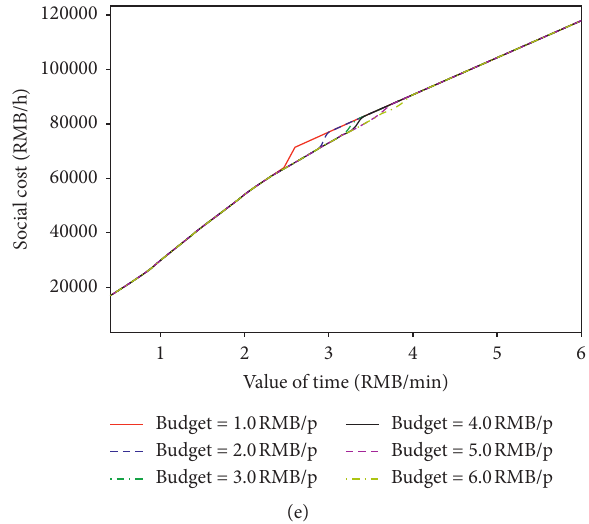
Figure 9: Variation of social cost components with VOT under different budget levels.